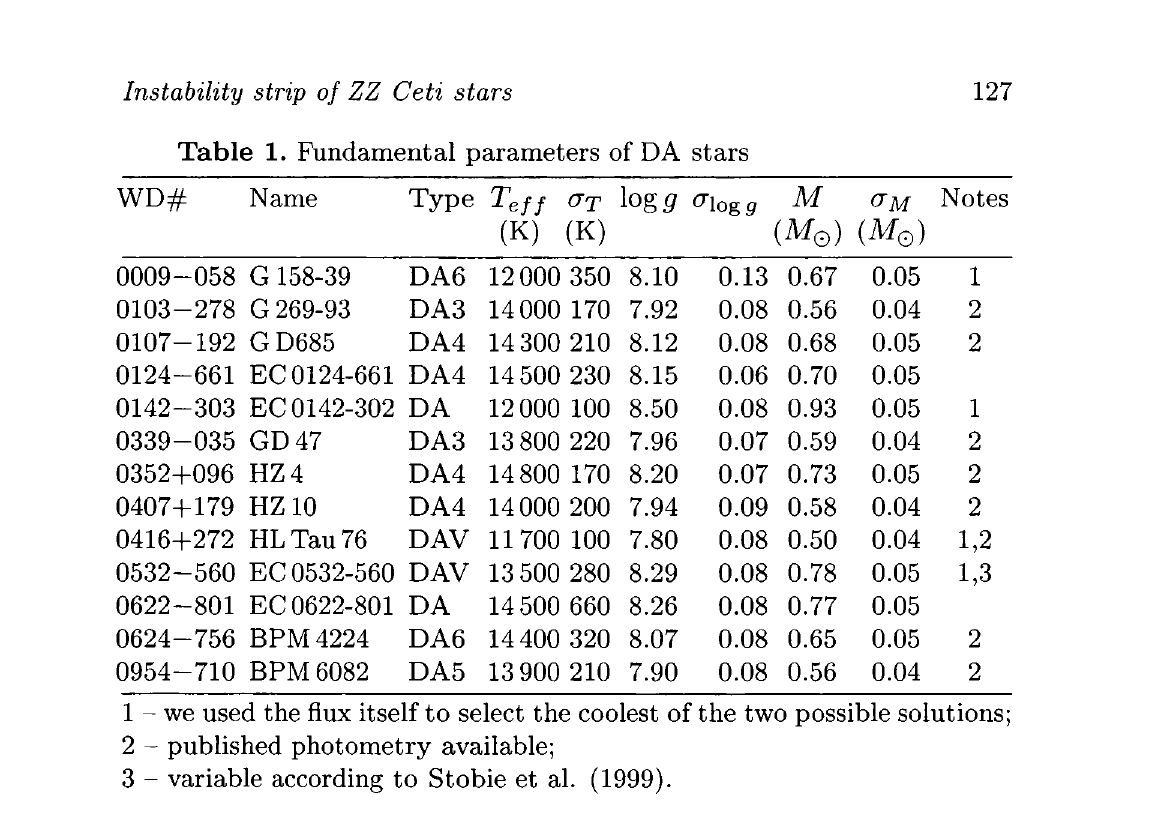
Table 1. Fundamental parameters of DA